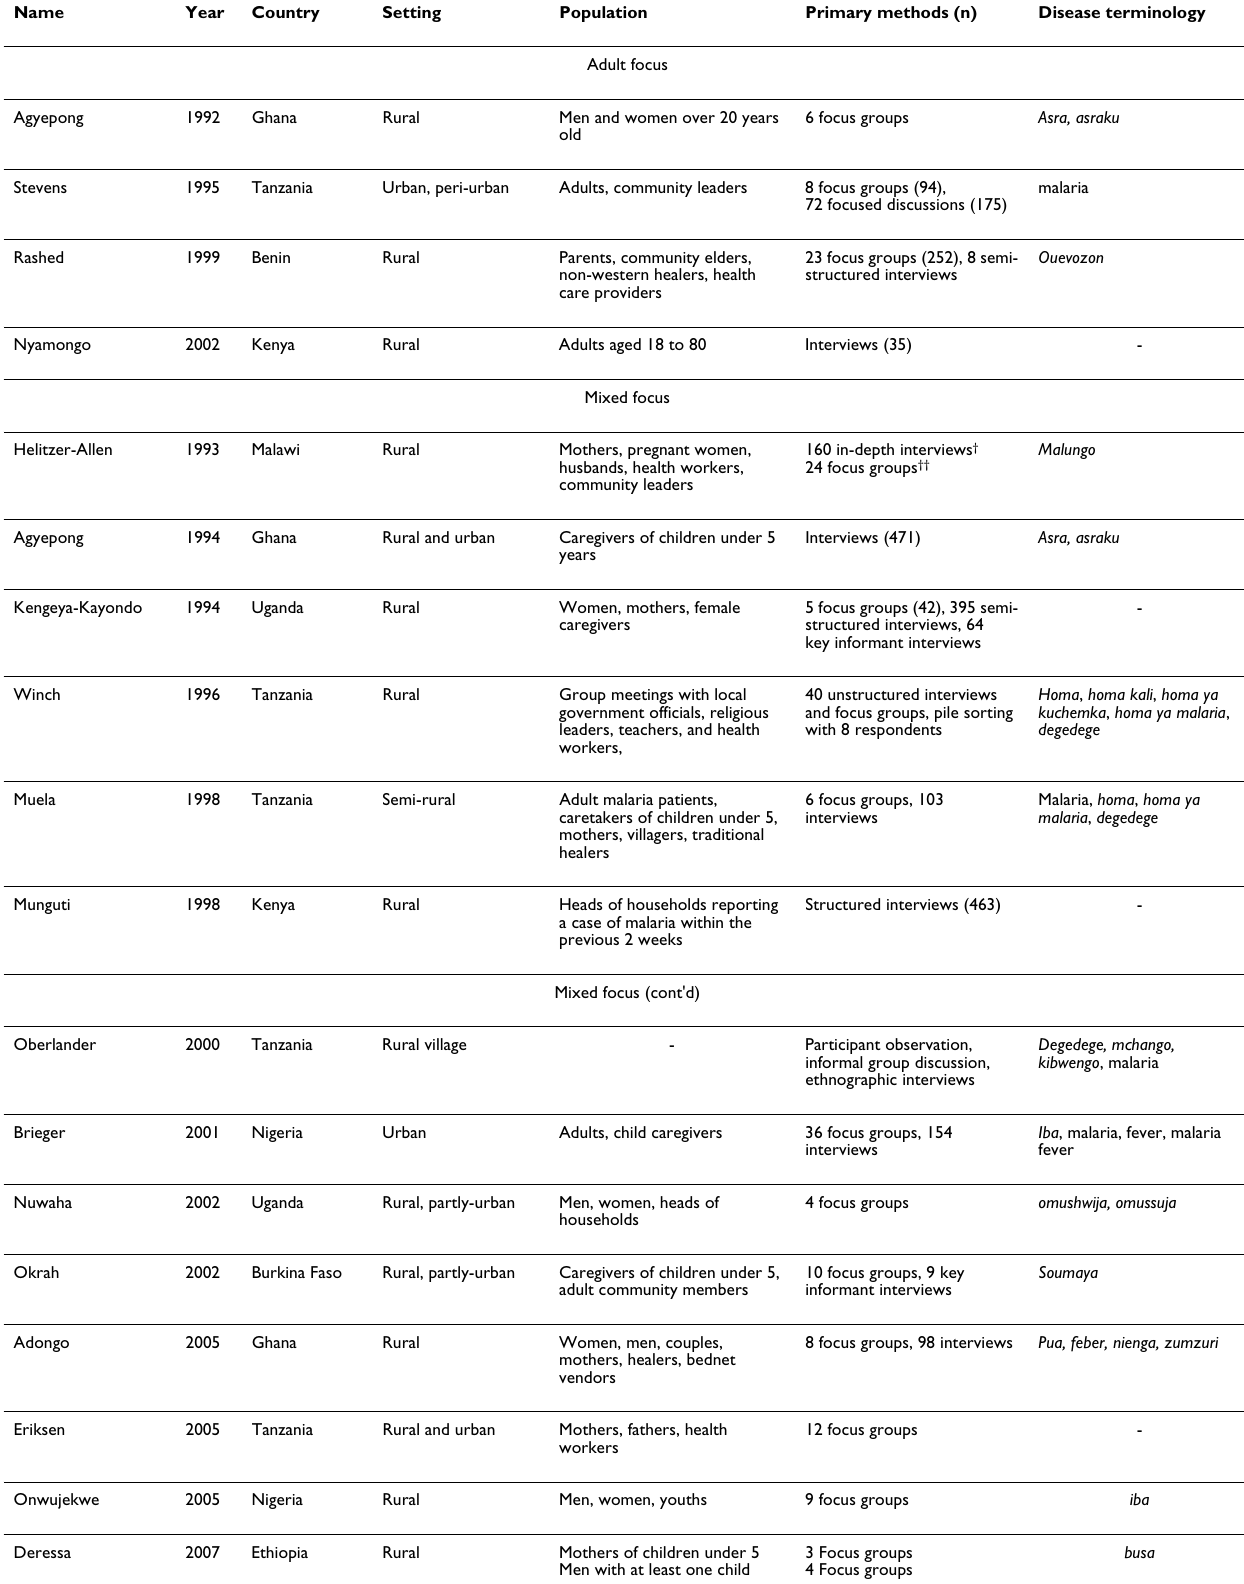
Table 2: Characteristics of qualitative studies in adults and mixed populations